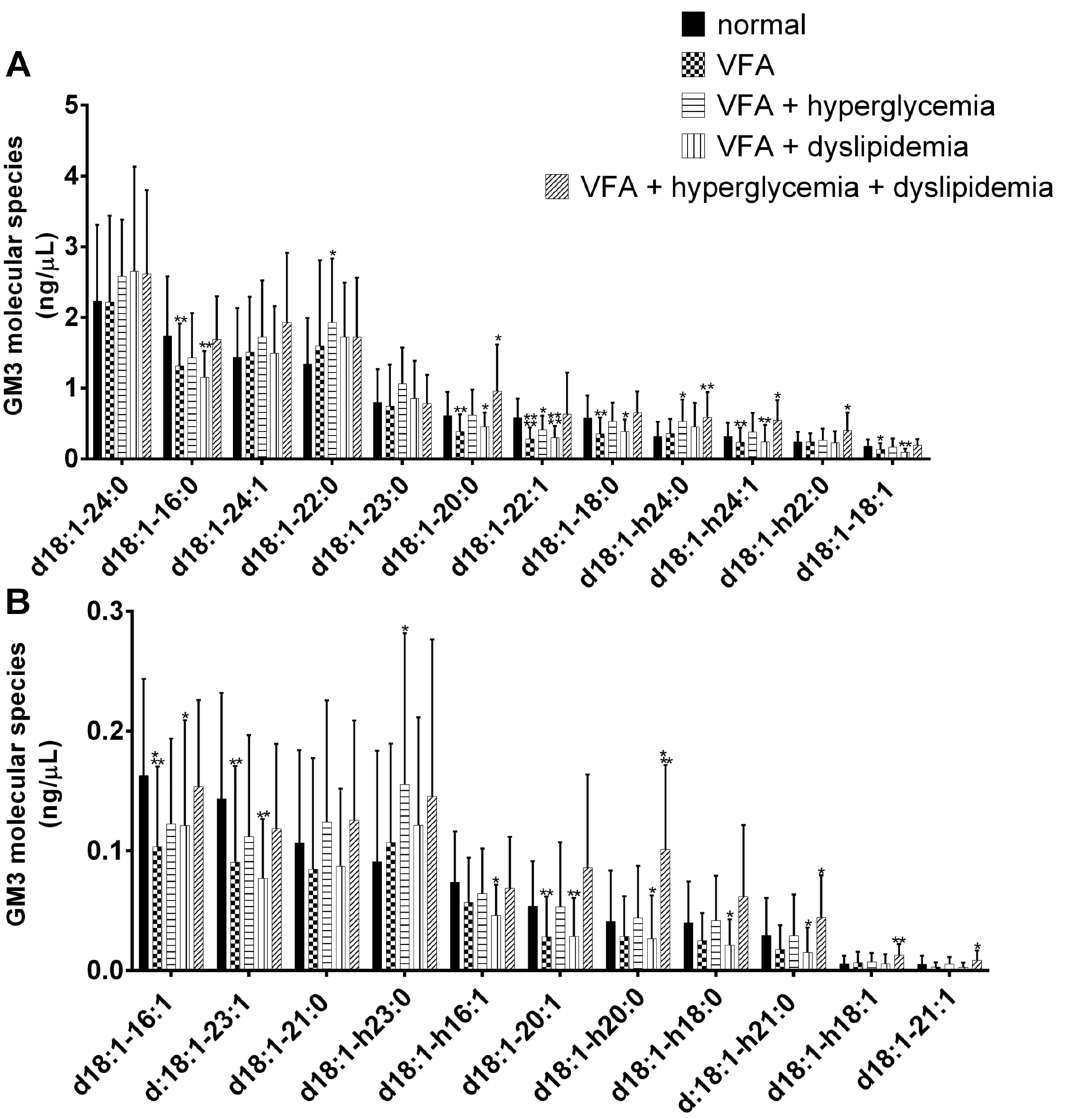
Fig 1. GM3 molecular species levels in human serum. Twelve most abundant (A) and eleven least abundant (B) GM3 molecular species detected in serum of patients with visceral fat accumulation (VFA) (n = 39), VFA with hyperglycemia (n = 15), VFA with dyslipidemia (n = 28) and VFA with both hyperglycemia and dyslipidemia (n = 17) compared with healthy lean control individuals (n = 26). Species were determined using LC-MS/MS MRM. Data are reported as means ± SD. * P (cid:3) 0.05, ** P (cid:3) 0.01, *** P (cid:3) 0.001, **** P (cid:3) 0.0001 metabolic risk factor groups vs. control; Mann-Whitney unpaired